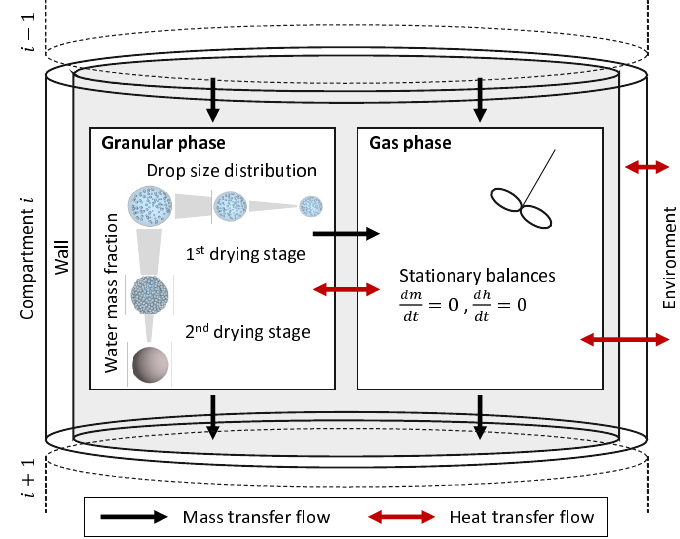
Figure 6. Model structure of a co–current spray drying process with compartmentalization along the vertical axis. In each compartment, the mass and heat transfer between the gas, granular, and wall phases are considered. A two-dimensional population balance approach allows for the consideration of the different drying kinetics before and after solidification.